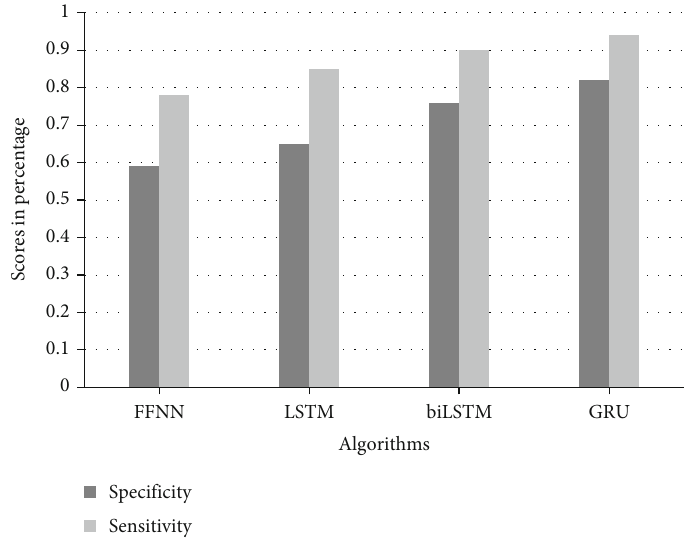
Figure 8: Speci fi city and sensitivity scores obtained by various